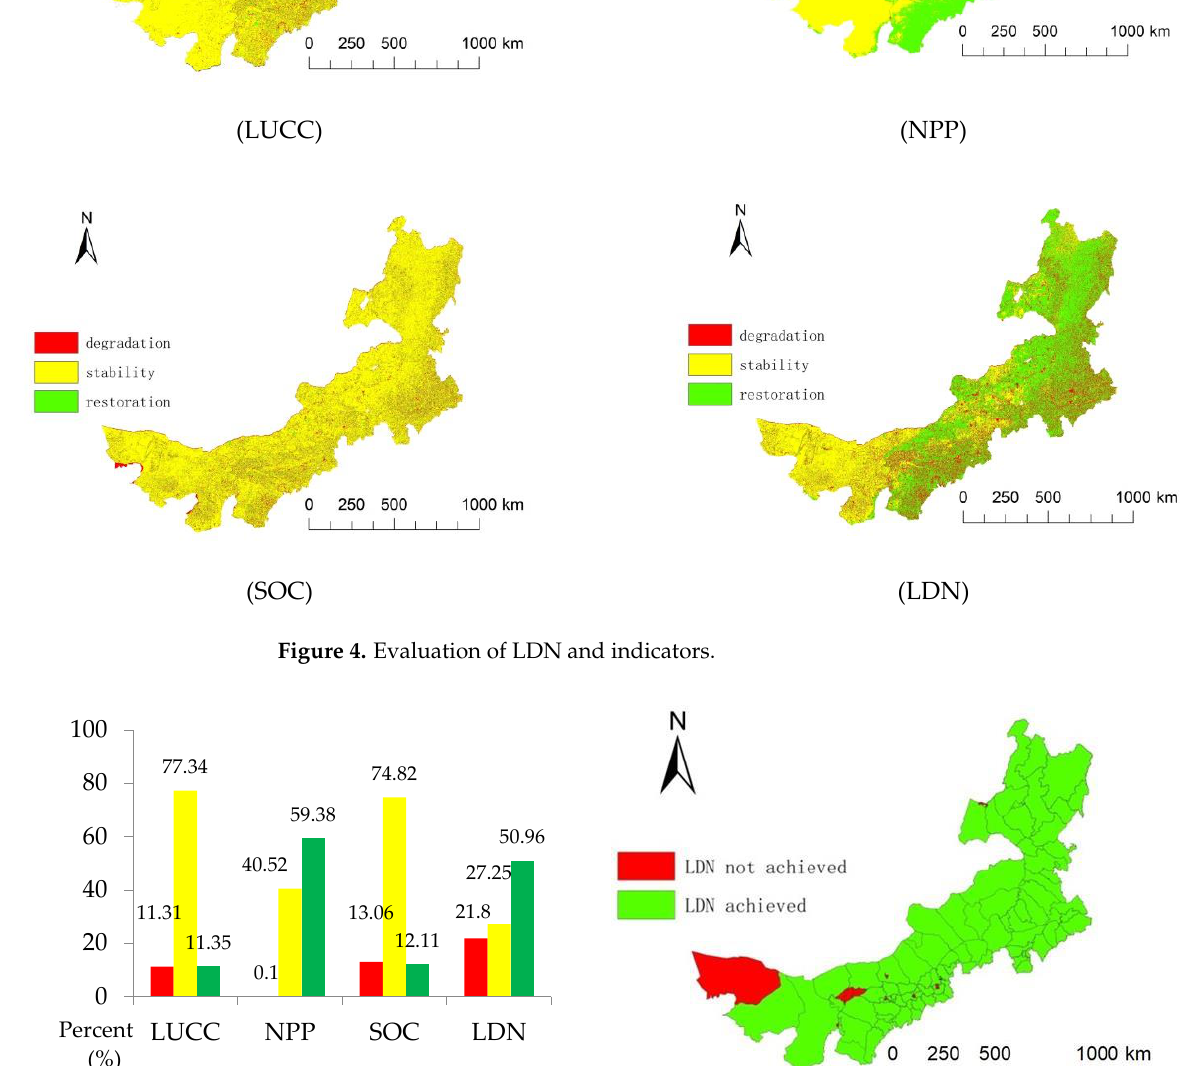
Table 4. Comparison of LUCC and LDN evaluation results before and after modification.